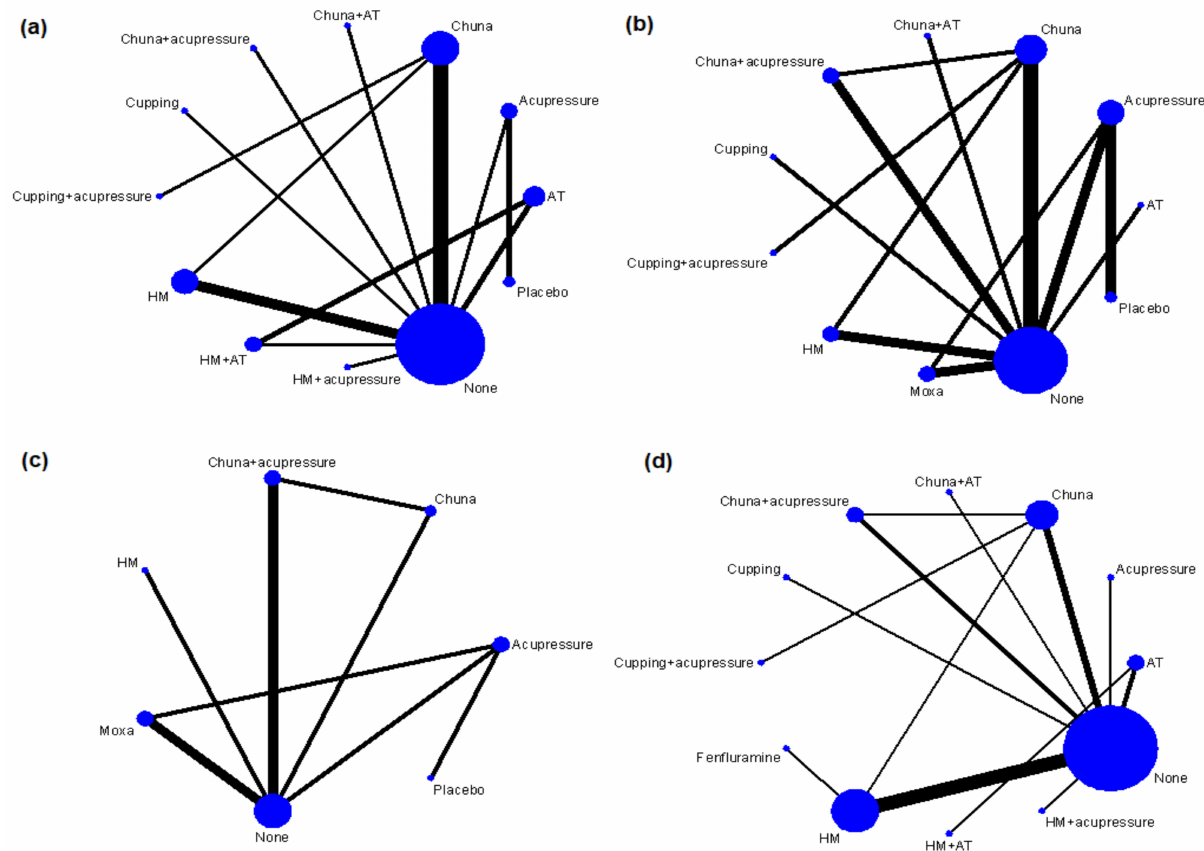
Figure 3. Network map of ( a ) body mass index, ( b ) body weight, ( c ) height, and ( d ) total effective rate. AT = acupuncture, HM = herbal medicine, Moxa = moxibustion, None = non-medical management. (2) Body